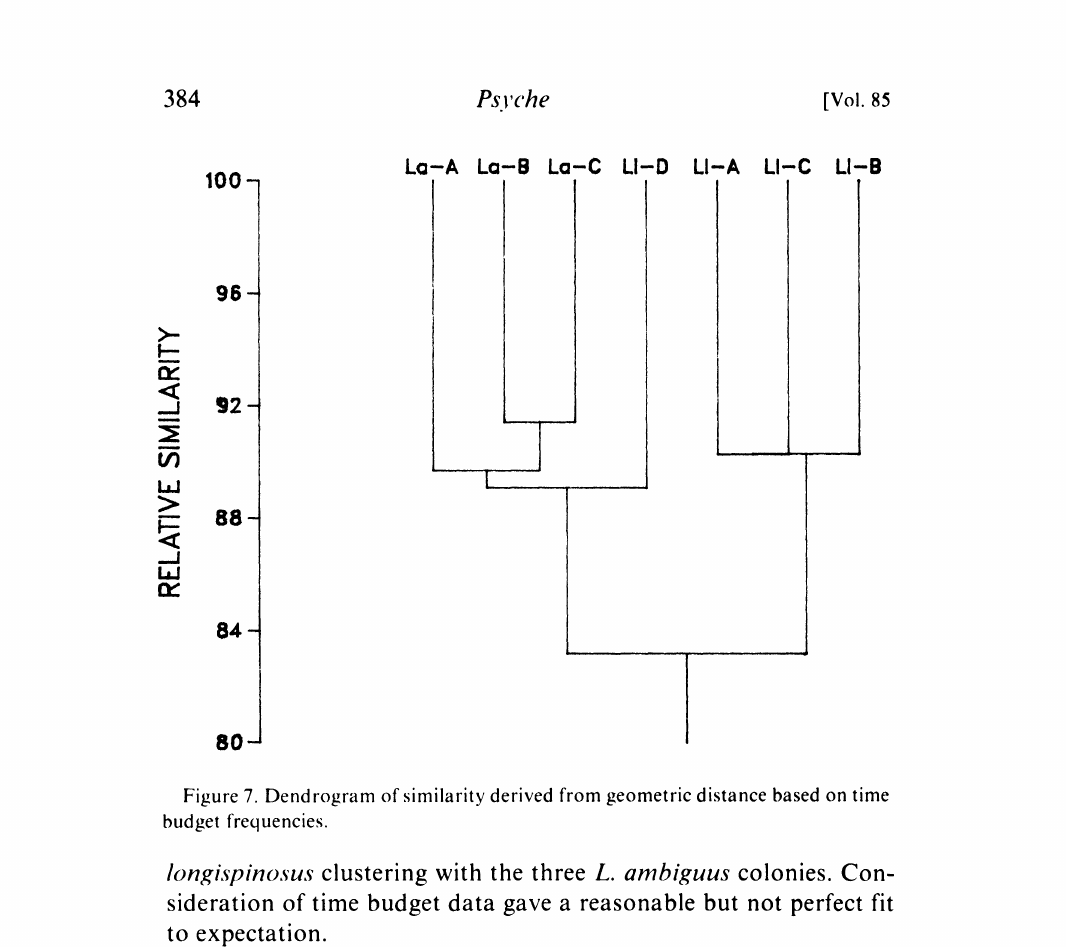
Figure 7. Dendrogram of similarity derived from geometric distance based on time budget